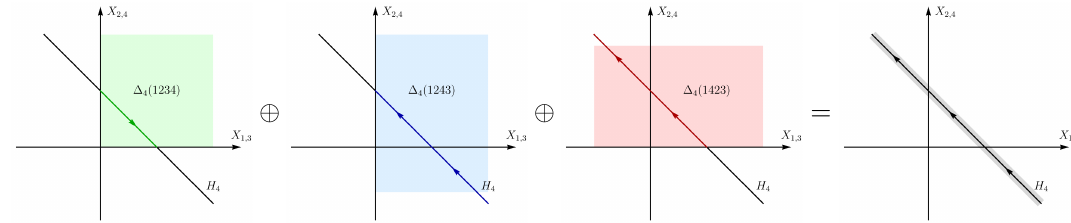
Figure 16 . Oriented sum of three associahedra for n = 4 producing an infinite